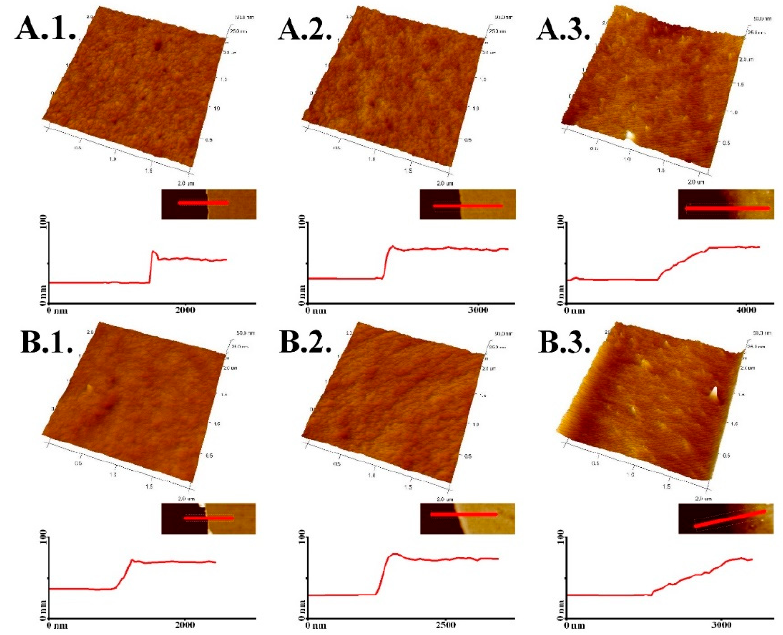
Figure 4. The topography and cross sections of C2H&AH PEMs on silicon for negatively (A panel) and positively charged topmost layer ( B panel) for dry ( A .1, B .1) and swollen films after 30 min incubation in PBS ( A .2, B .2) or 1 M NaCl solution ( A .3, B .3).